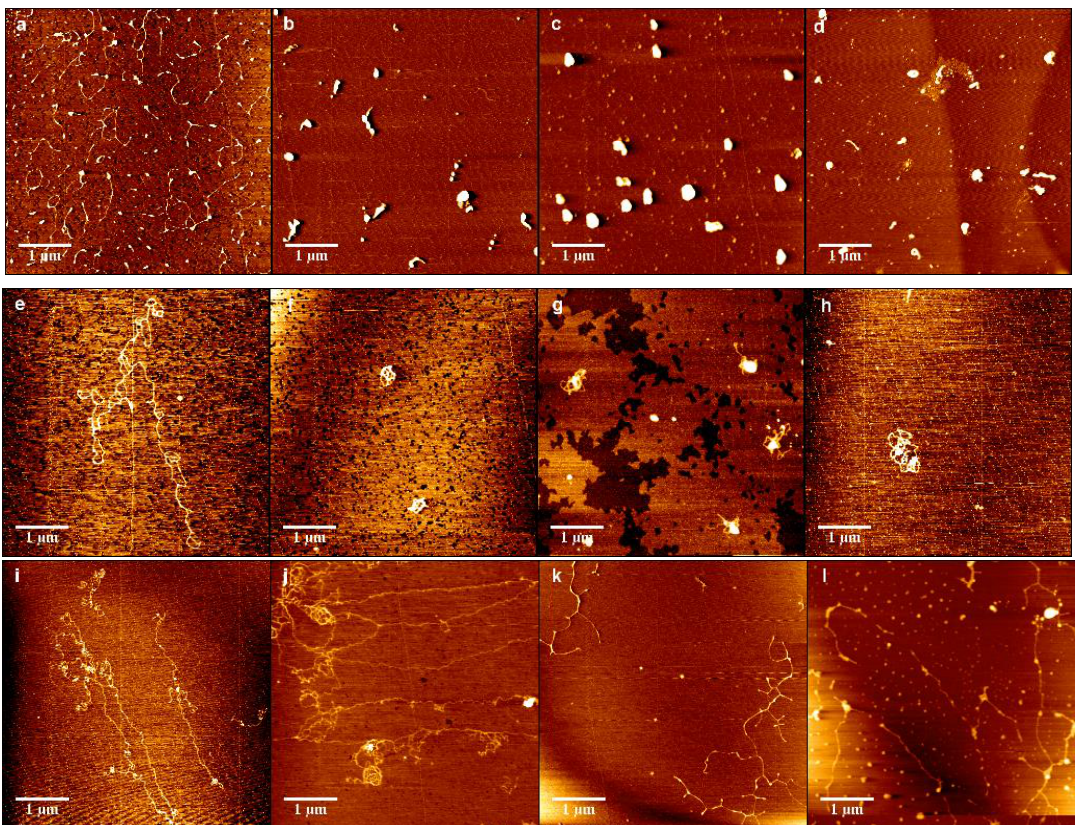
Figure 8. Atomic force images of DNA-chitosan complexes at different chitosan concentrations and pHs. The concentration of Figure ( a – d ) chitosan is 0.1 µ M, 0.15 µ M, 0.35 µ M, 0.45 µ M, ( k = 0.95,1.43,3.33,4.28) respectively, pH = 4.6. Similarly, in ( e – h ), the concentration of chitosan is 0.15 µ M, 0.2 µ M, 0.25 µ M, 0.3 µ M, ( k = 1.43,1.9,2.38,2.85), respectively, pH = 7. In ( i – l ), the concentration of chitosan is 0.2 µ